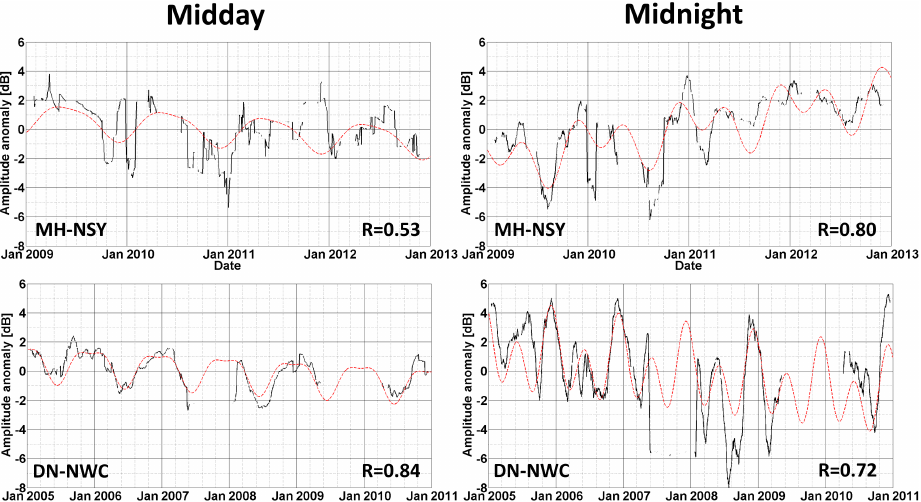
Figure 2. Midday (left panels) and midnight (right panels) 1h mean 30-day running-average time series of MH-NSY (top panels) and DN- NWC (bottom panels) transmitter–receiver GCP deviation from the mean amplitude (solid black curves). The dashed red curves show the combination of the SAO, AO, and linear fit to the data time series (see Eq. 1). A Pearson’s correlation coefficient between the red and black curves is shown at the bottom right of each